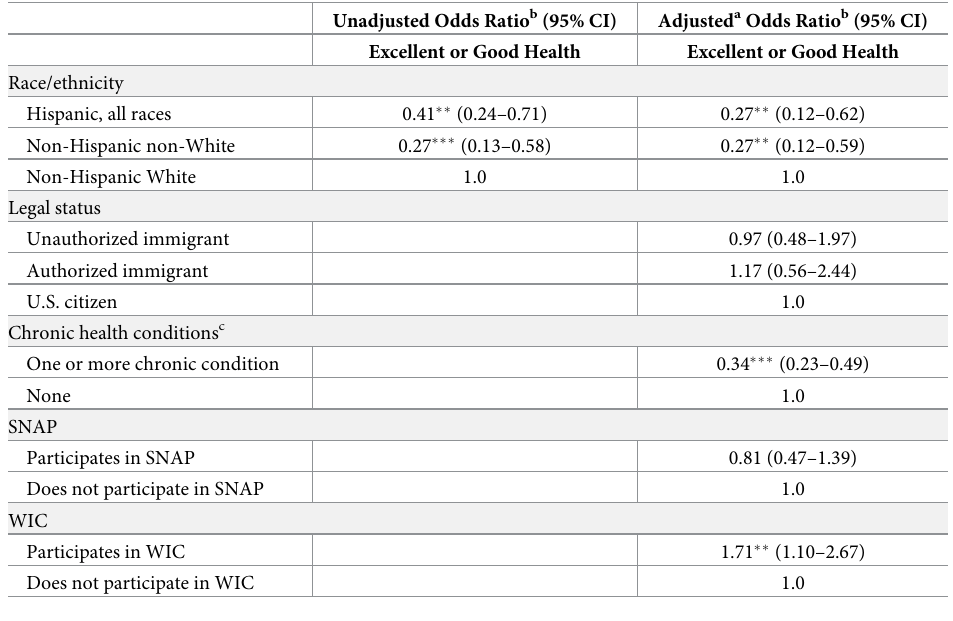
Table 2 shows the odds ratios (OR) corresponding to SRH by race and ethnicity. Compared to non-Hispanic White farmworkers, those who identified as Hispanic were less likely to report excellent or good health (OR 0.27, 95% CI 0.12–0.62). Similar findings were estimated for non-Hispanic non-White farmworkers, who were less likely to report excellent or good Table 2. Odds of self-reporting excellent or good health vs. fair or poor health among U.S. farmworkers by race and ethnicity: National Agricultural Workers Survey (NAWS), 2009/2010 (n =